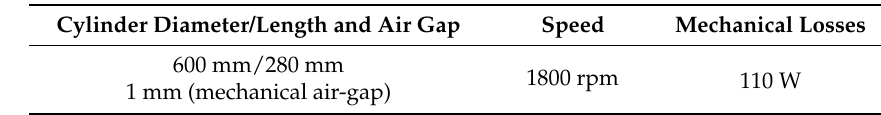
Table 12. Air friction